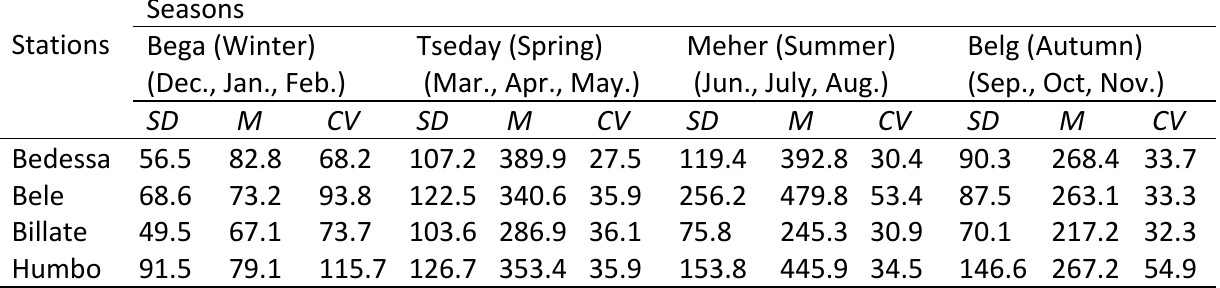
Seasonal Average Rainfall (mm), for Four Meteorology Stations in the Study Area (2000 − 2019)